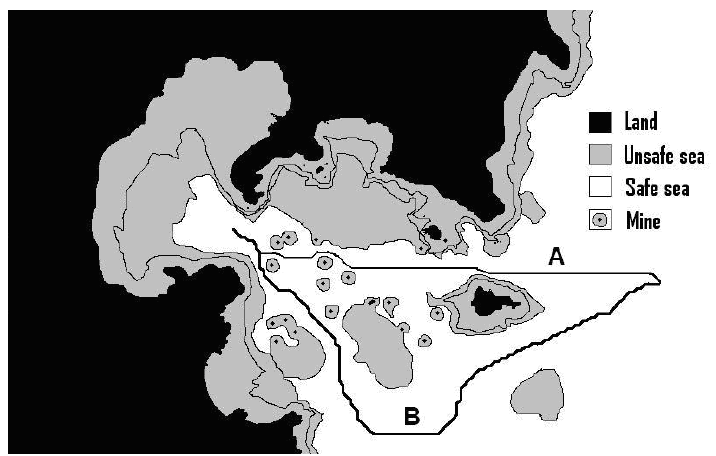
Figure 10: Shortest (A) and safest (B) routes through a minefield, considering environmental factors (grid spacing 50% (100m), safety radius =